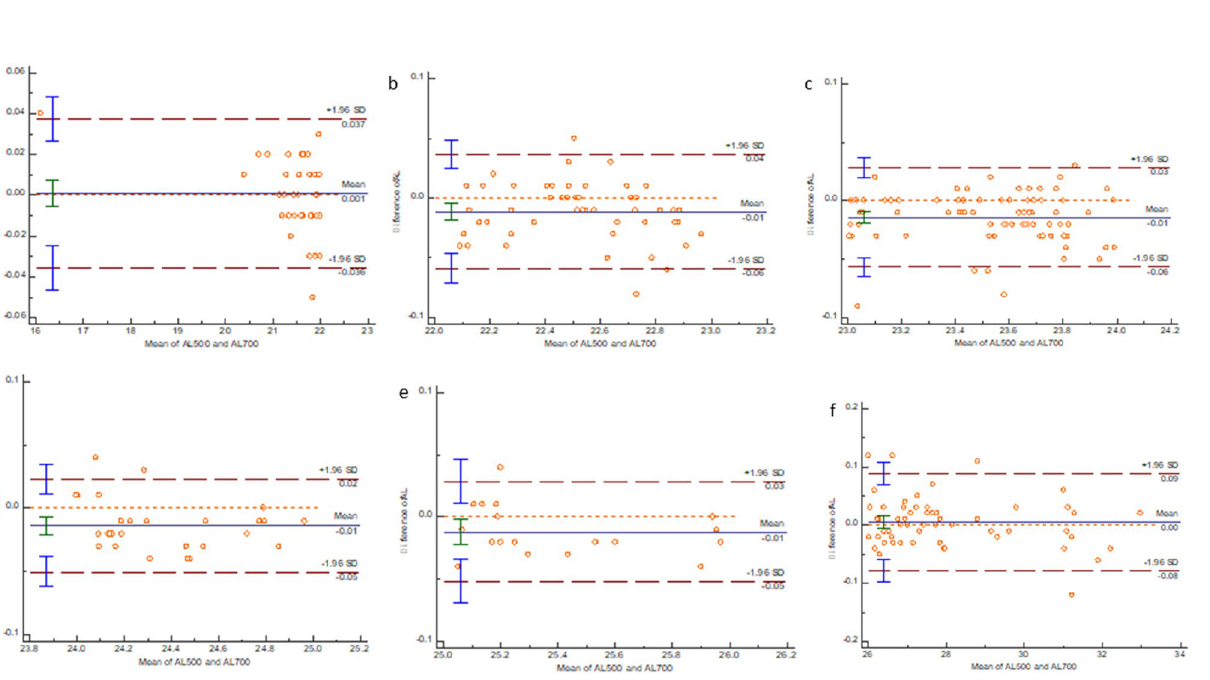
Figure 1. The Bland–Altman plot showing the results of AL measurement by the two instruments. ( a ) AL < 22.00 mm group. ( b ) 22.00 mm ≤ AL < 23.00 mm group. ( c ) 23.00 mm ≤ AL < 24.00 mm group. ( d )